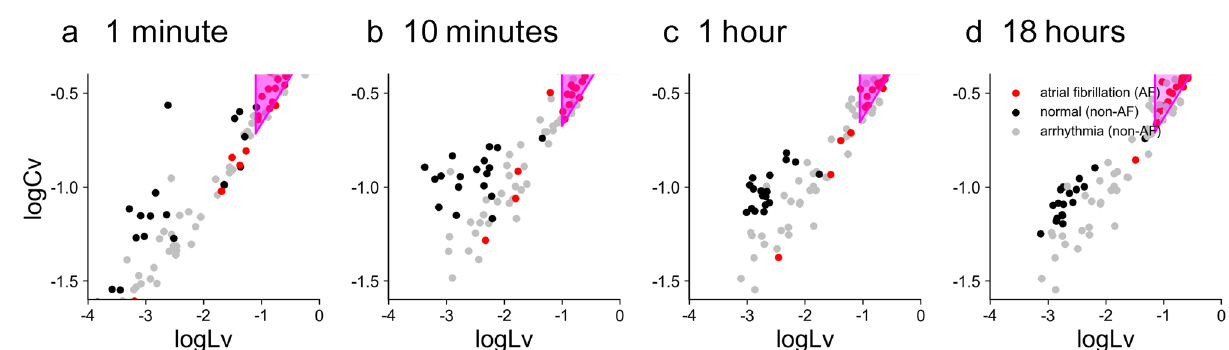
Figure 8. Two metrics log 10 Lv and log 10 Cv computed for three kinds of MIT-BIH databases. ( a ), ( b ), ( c ), and ( d ): Datasets of 1 minute, 10 minutes, 1 hour, and 18 hours plotted on a plane spanned by the two metrics. The parameters a and b of the prediction zone (magenta) for the AF cases were adapted to respective